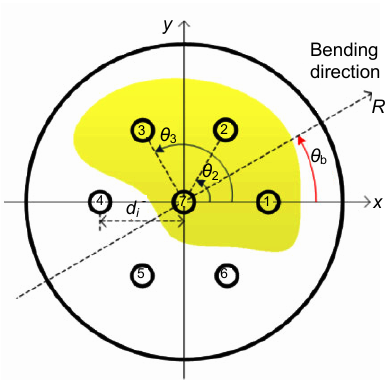
Fig. 3 | The transversal spatial distribution of cores of a sev- en-core fiber, showing the definitions of some important geo- metrical parameters . Figure reproduced from ref. 25 , Optical Society of America.